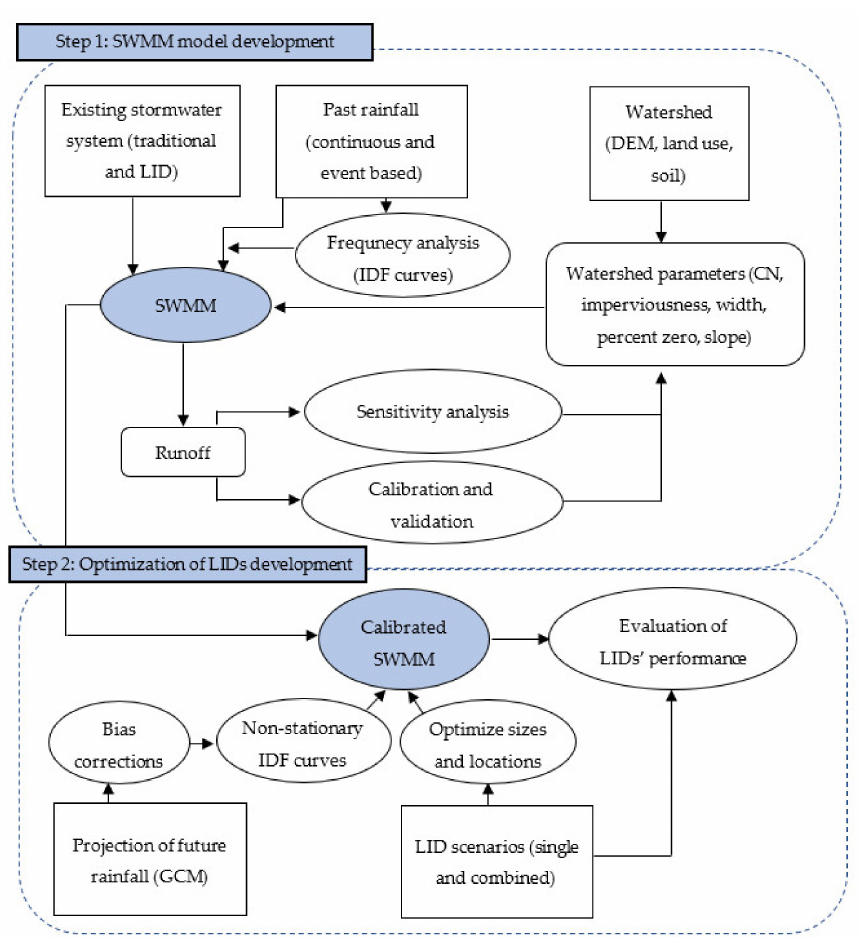
Figure 4. Schematic diagram outlining the steps and methodologies involved in developing the SWMM model and assess effectiveness of the LIDs.